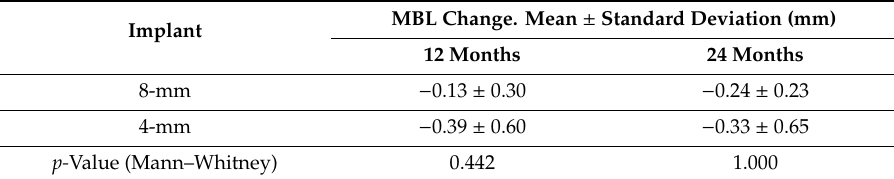
Table 5. MBL change (mm) ± standard deviation by stage and implant type.